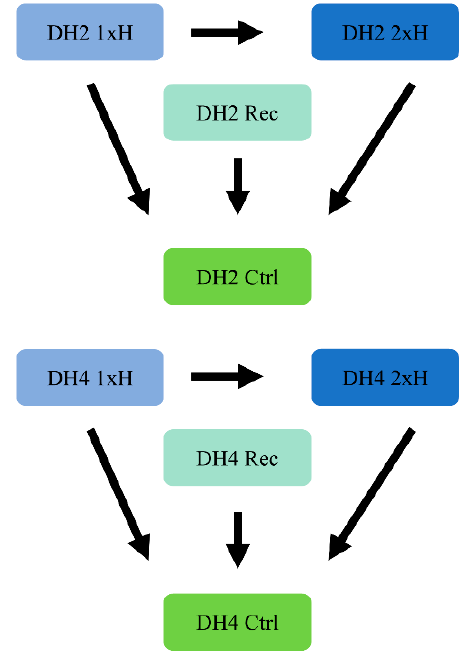
Figure 2. Strategy for differentially expressed genes (DEGs) identification. The arrow direction depicts the comparisons carried out in the analysis.